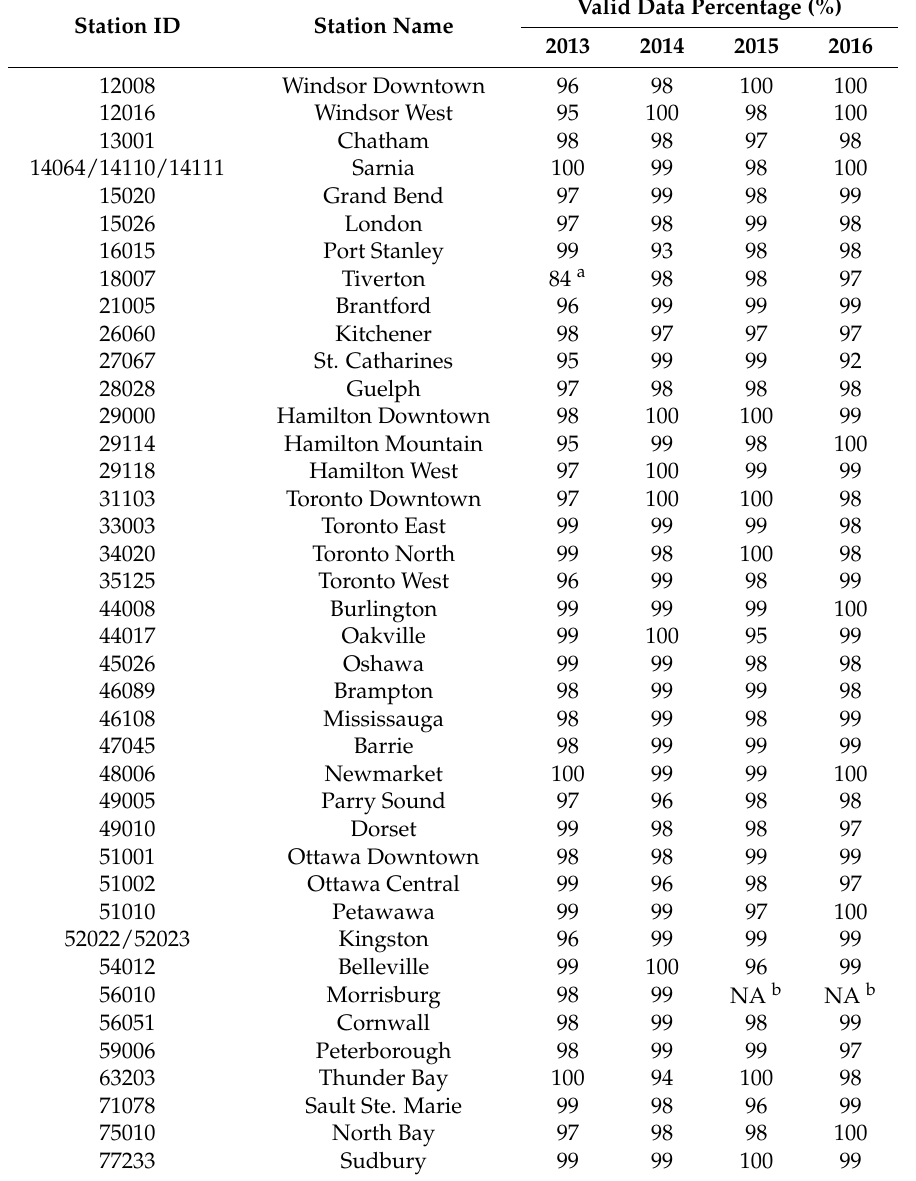
Table 2. Annual valid data percentages of the Synchronized Hybrid Ambient Real-time Particulate (SHARP) 5030 from 2013 to